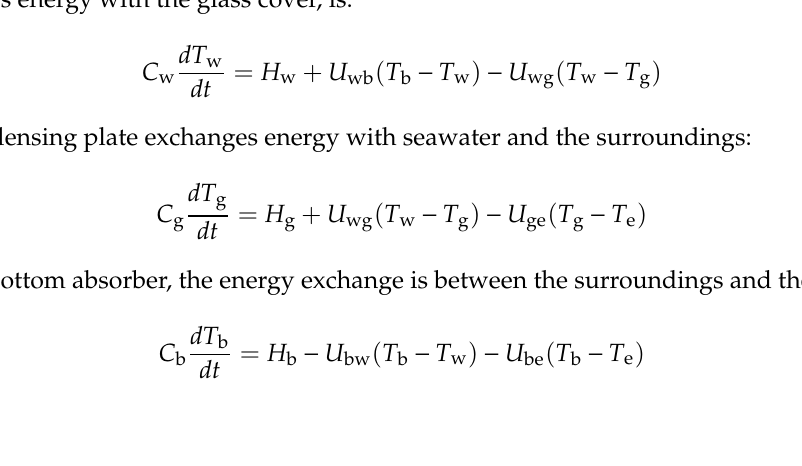
Figure 2. Heat ‐ transfer exchange mechanisms in a solar still. Figure 2. Heat-transfer exchange mechanisms in a solar